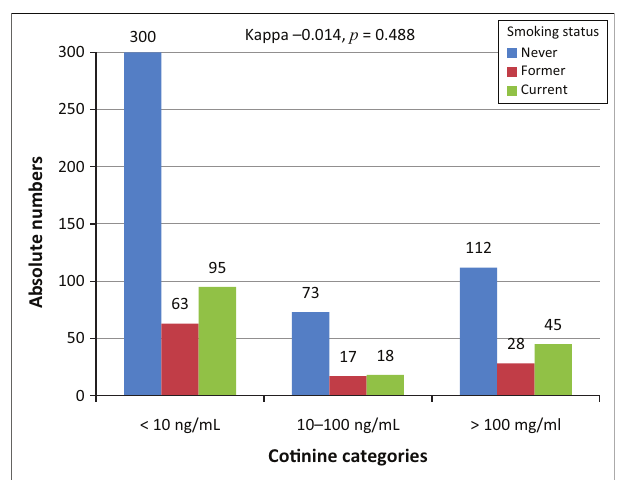
FIGURE 3: Agreement between self-reports and cotinine levels at ranking smoking status.